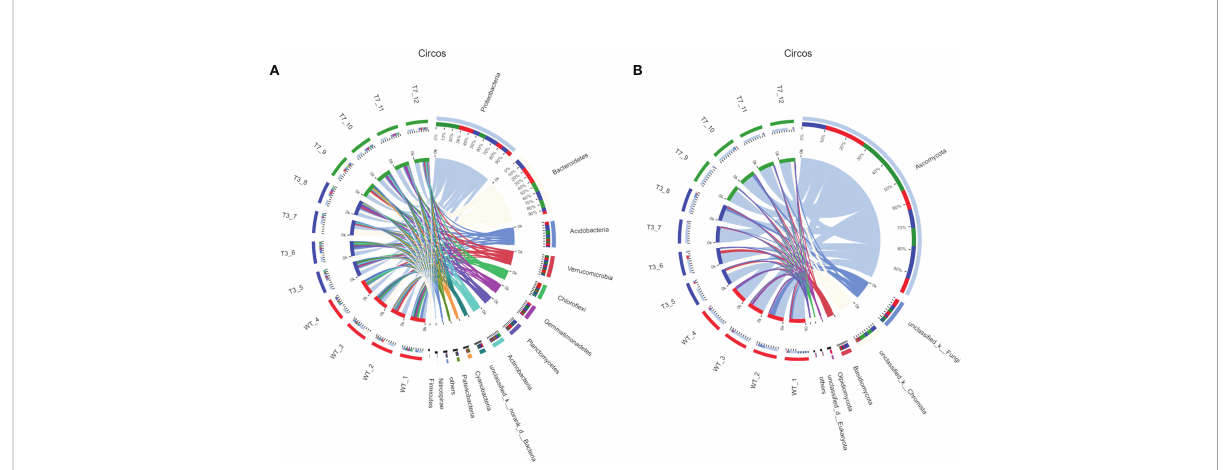
FIGURE 3 Circos diagram of bacteria and fungi at the genus level in different generations ( A , bacteria; B , fungi). Note: The small semicircle (left half circle) represents the species composition in the sample. The large semicircle (right half circle) represents the distribution ratio of species in different samples at the taxonomic